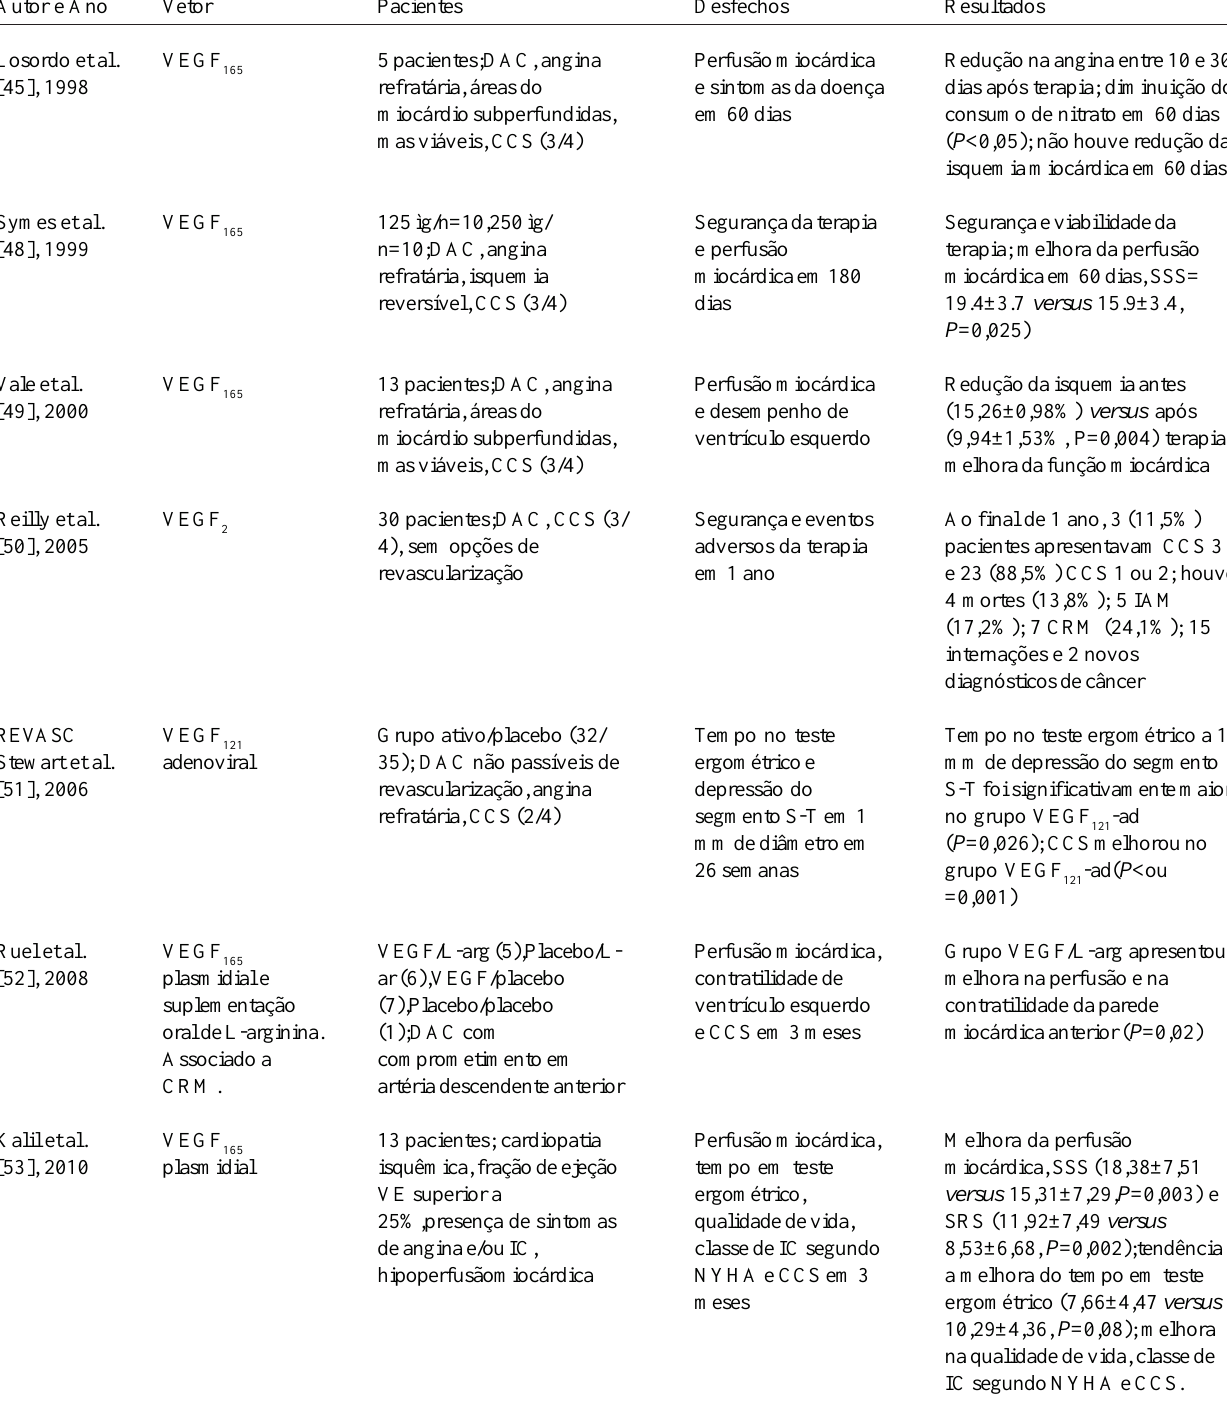
VEGF: Fator de Crescimento do Endotélio Vascular; DAC: Doença arterial coronariana; CCS: Classe de Angina; Ad: adenoviral; P: Placebo; IAM: Infarto Agudo do Miocárdio; CRM: Cirurgia de Revascularização Miocárdica; G-CSF: Fator Estimulante de Colônias de Granulócitos; L-arg: L-arginina; VE: Ventrículo Esquerdo; IC: Insuficiência Cardíaca; NYHA: New York Heart Association; SSS: Escore Somado de Estresse em cintilografia ; SRS: Escore Somado de Repouso em